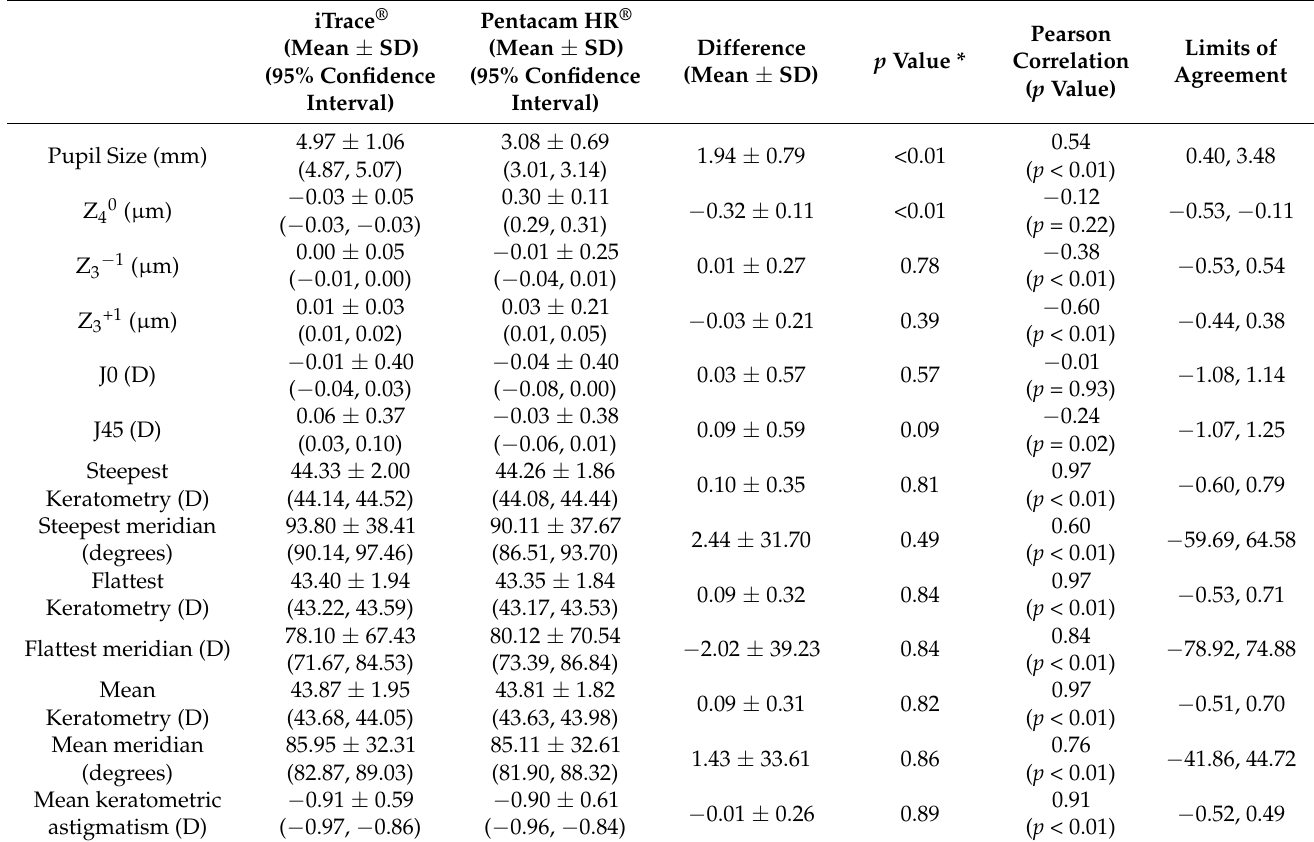
Table 1. Mean values measured by iTrace ® and Pentacam HR ®